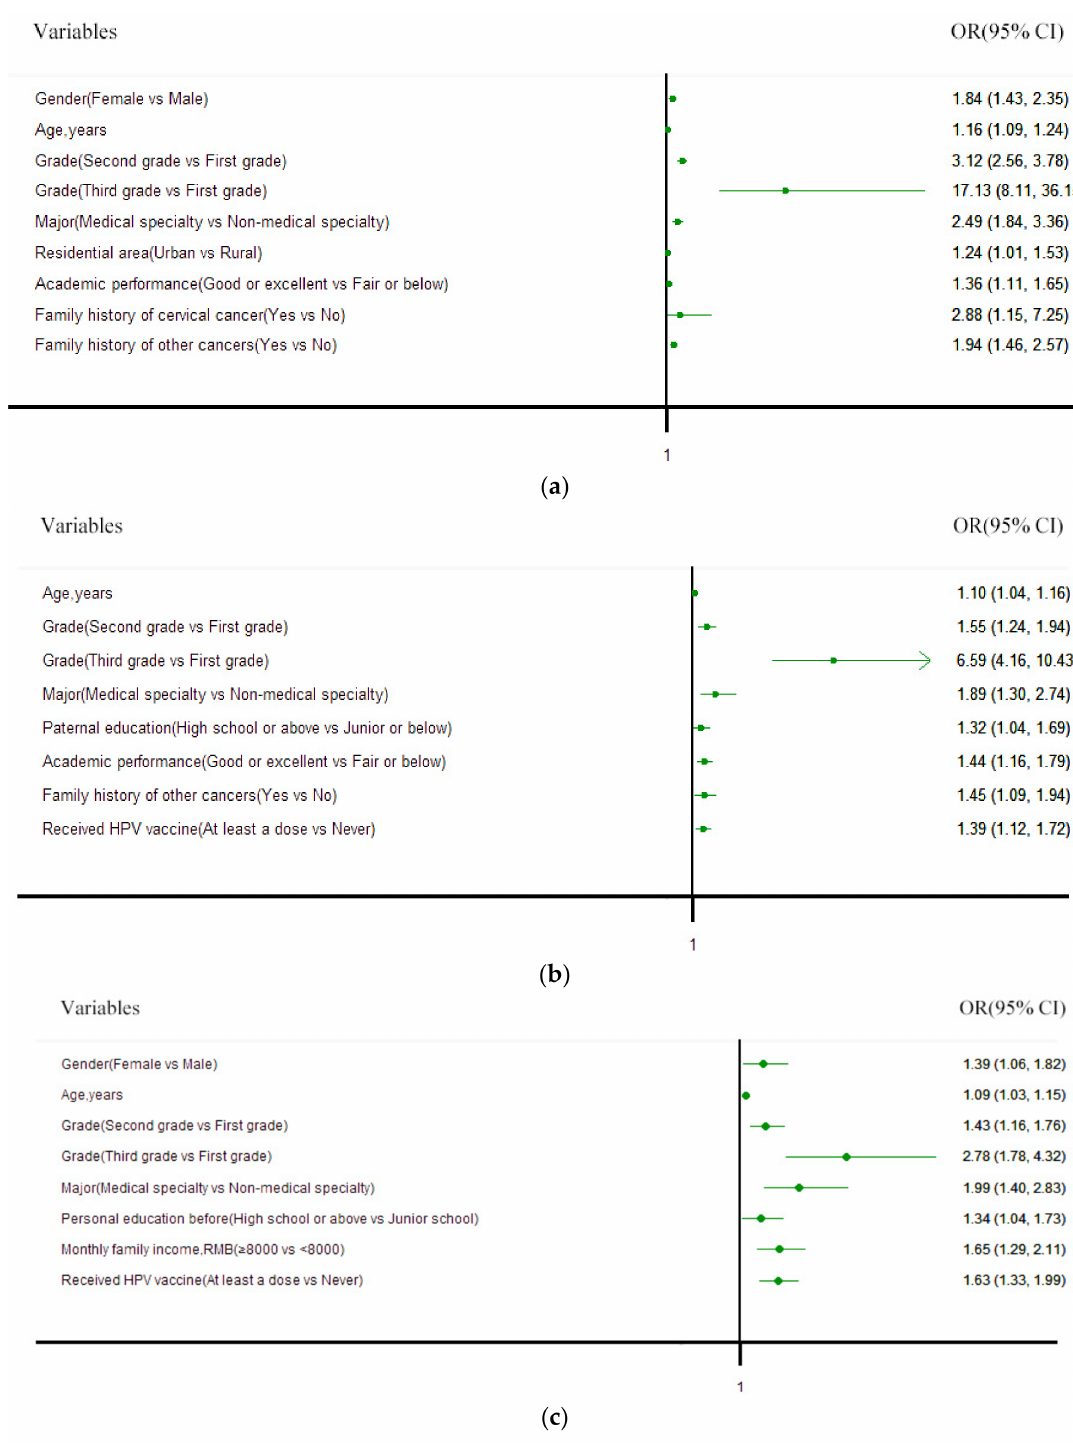
Figure 2. The forest plots of multivariable logistic regression analysis for awareness of: ( a ) CC (cervical cancer); ( b ) human papillomavirus (HPV); ( c ) the HPV